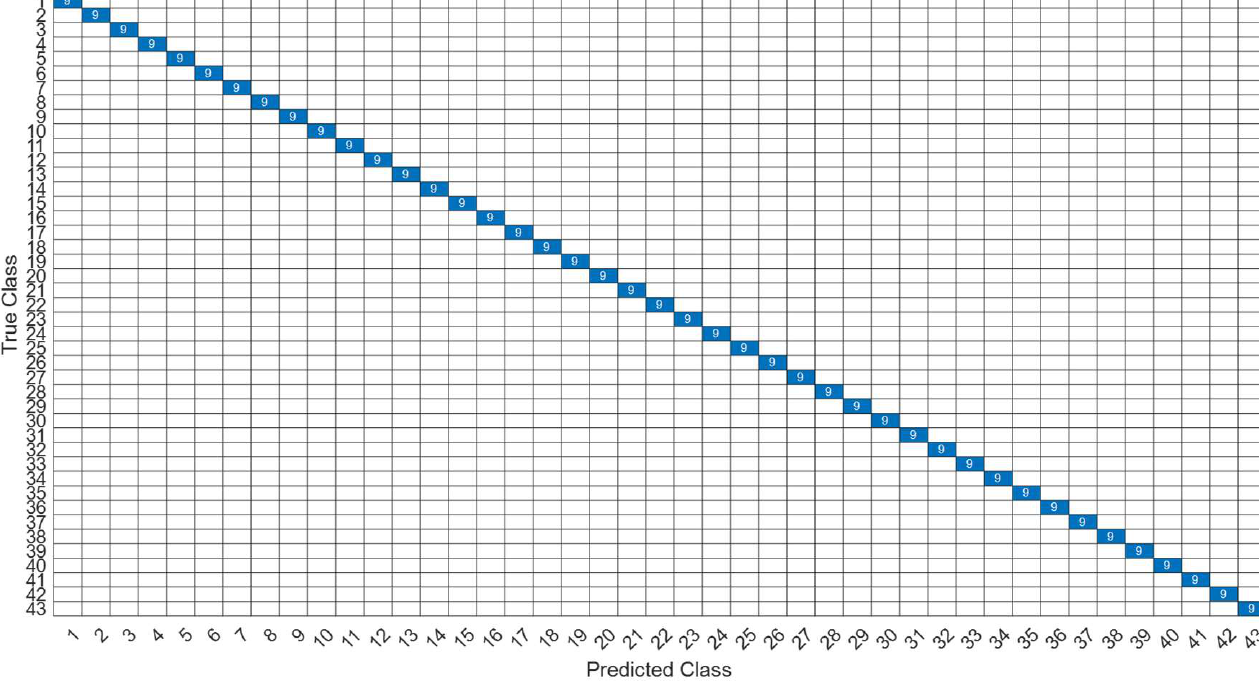
Figure 23. The confusion matrix of the DNN model with wavelet 30-features dataset.